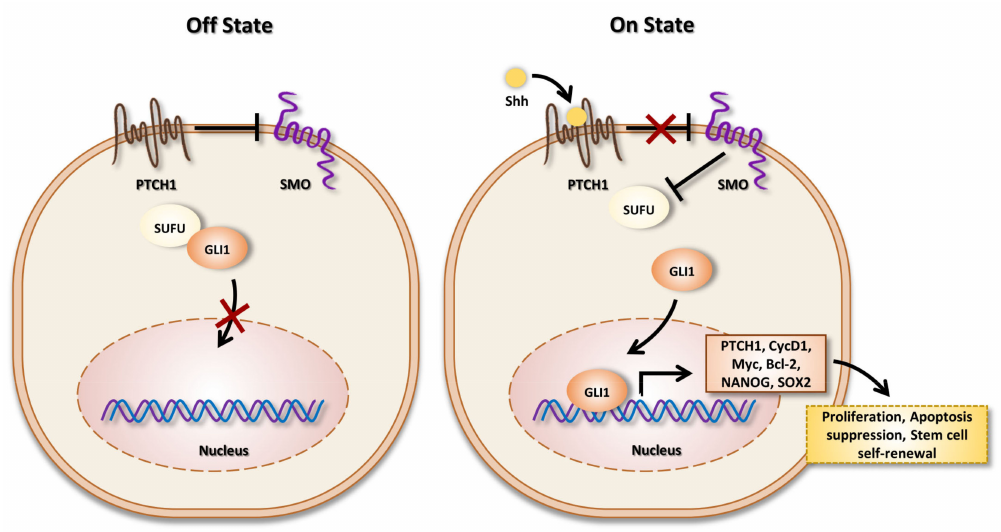
Figure 1. O ff state ( left ): In the absence of Sonic Hedgehog (SHH) ligand, Ptch inhibits signal transduction by SMO. Gli canonical SHH signaling pathway proteins are sequestered in the cytoplasm by interaction with Sufu. Therefore, the expression of SHH signaling targets turns o ff . On state ( right ): In the presence of ligand, SHH binds to Ptch and, therefore, induces the translocation of SMO to the primary cilium, a subcellular compartment essential for signal transduction to the positive forms of Gli proteins. Gli proteins accumulate into the nucleus and activate target genes